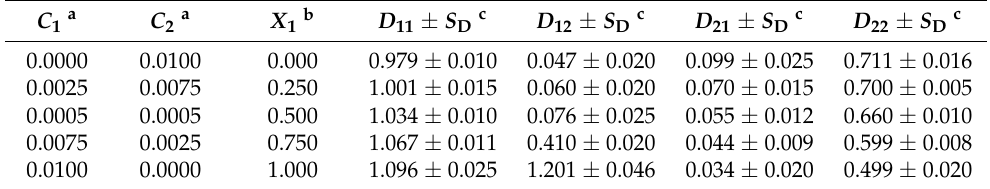
Table 1. Experimental ternary mutual diffusion coefficients, D 11 , D 12 , D 21 , and D 22 , of aqueous NaSal ( C 1 ) + Na 4 EtRA ( C 2 ) solutions at T = 298.15 K and P = 101.3